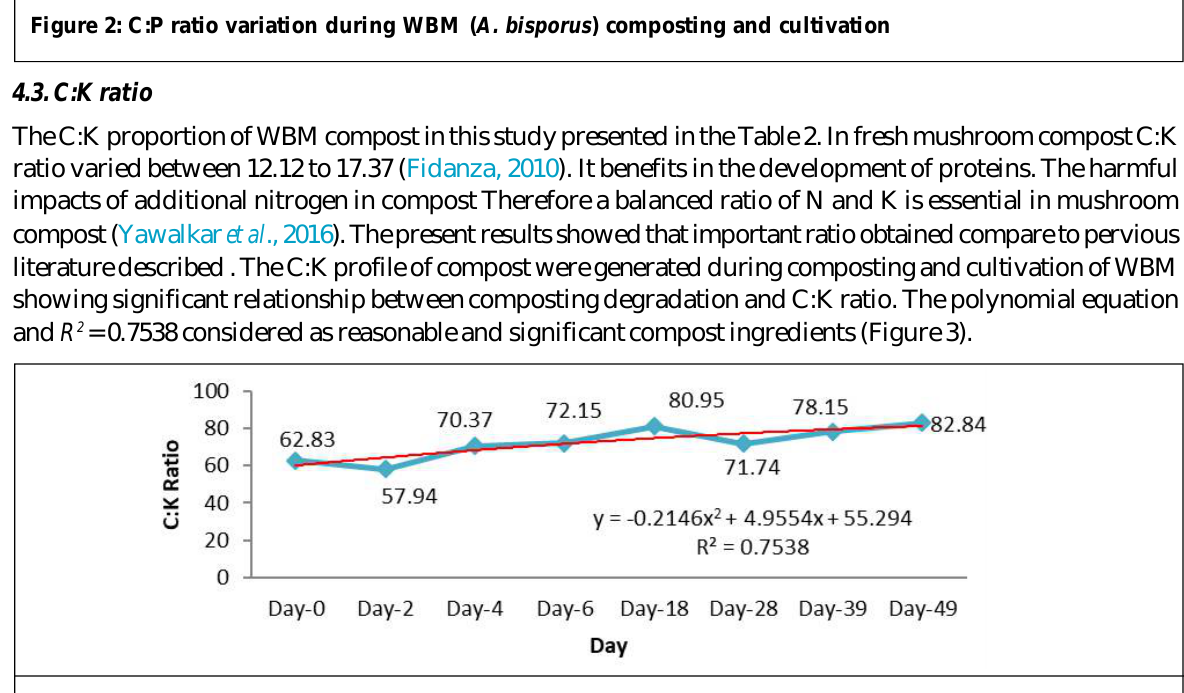
Figure 3: C:K ratio variation during WBM ( A. bisporus ) composting and cultivation